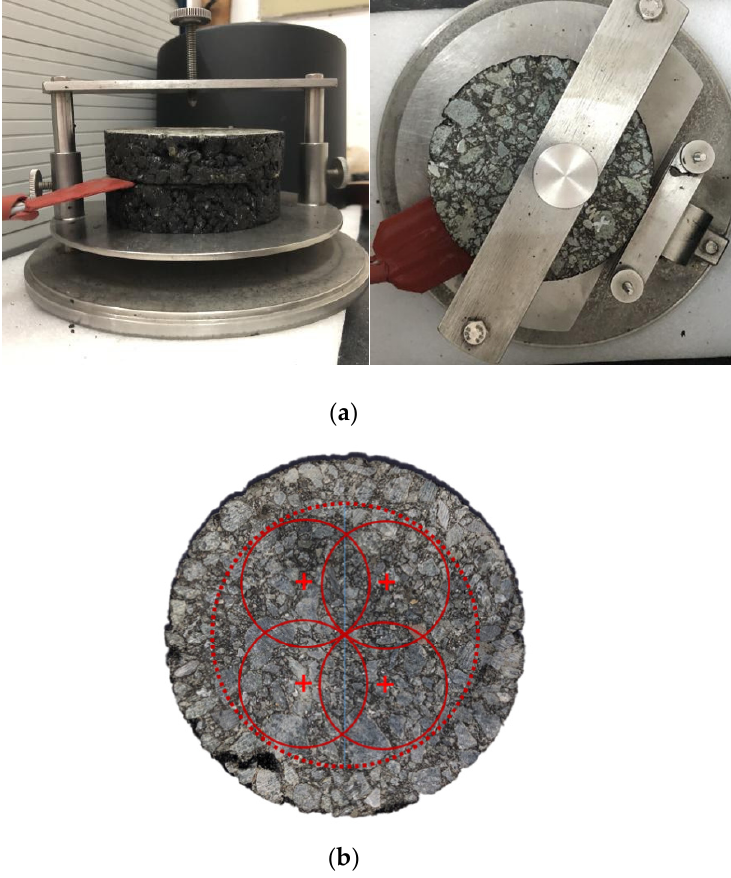
Figure 2 Test area of thermal properties test. Figure 2. Test area of thermal properties test. ( a ) Test system; ( b ) Test